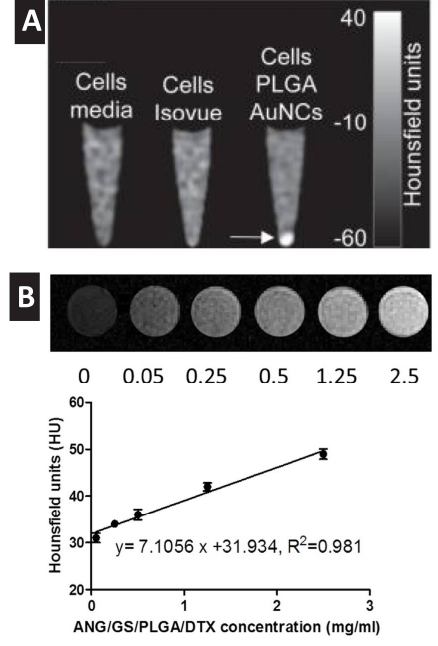
Figure 4. ( A ) In vitro CT image of macrophage cells (J774A) incubated with poly(lactic-co-glycolic acid) (PLGA) nanocarriers encapsulating GNP [arrow]. ( B ) In vitro X-ray CT images [upper panel]